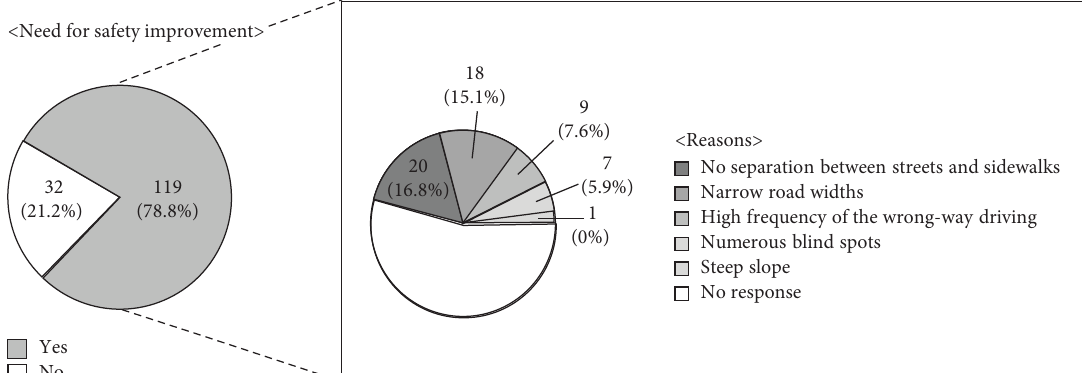
Figure 11: Responses to question about need for safety